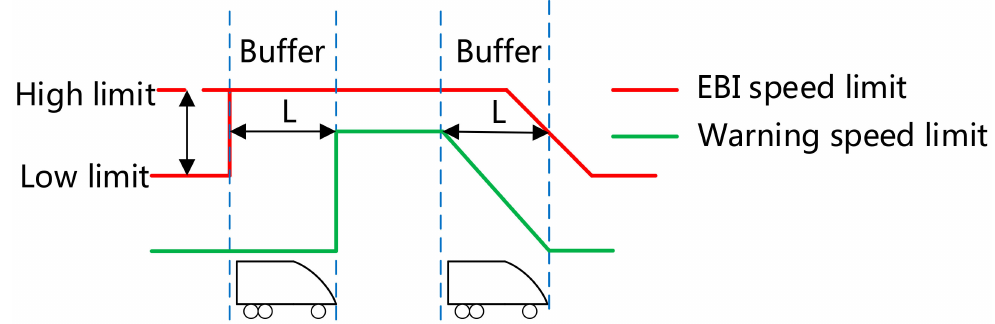
Figure 8. Safety speed limit.